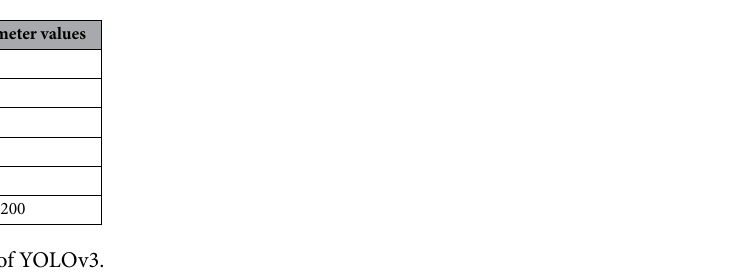
Table 7. Some parameters of